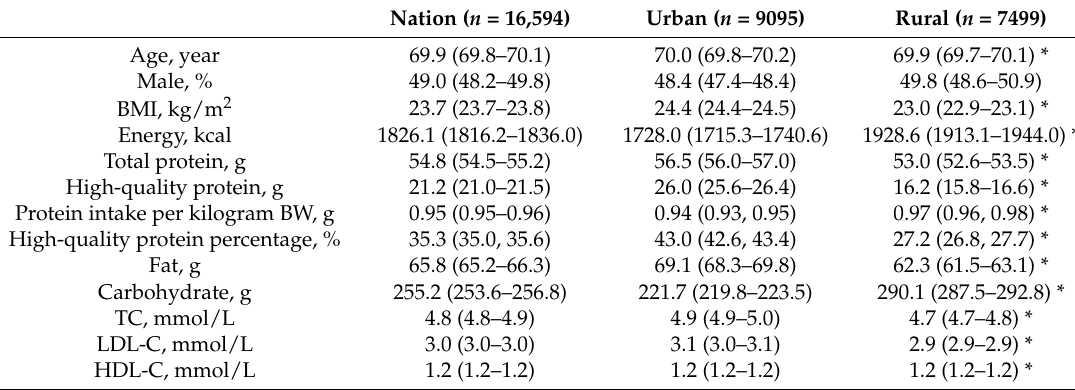
Table 1. Demographic and dietary characteristics of people aged 60 and above in urban and rural areas in